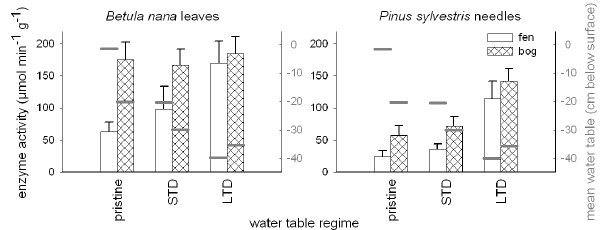
Fig. 3. Direct effects of water table (WT) drawdown and site nutri- ent regime on activities of C-acquiring enzymes. Enzyme activity data are presented as averages per litter type and plot (nutrient and WT regime), the error bars represent standard error of mean. Site WT regimes: STD, short-term WT drawdown; LTD, long-term WT drawdown.